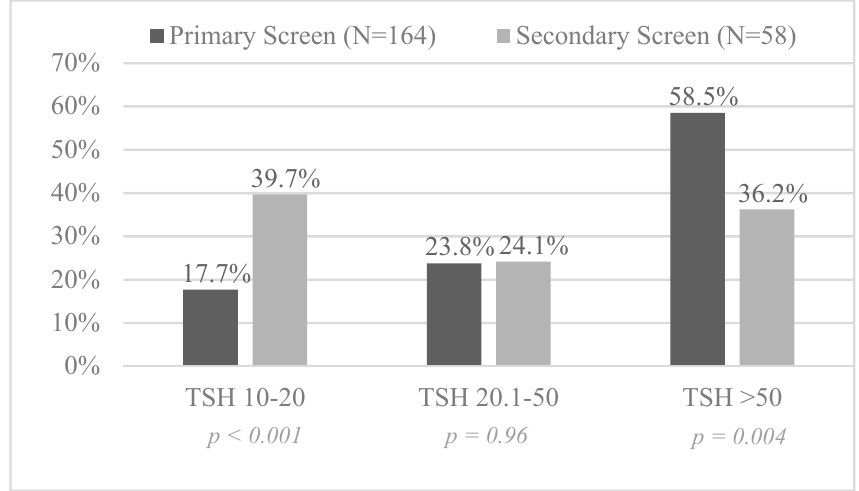
Figure 2. Comparison of initial TSH (mIU/L) levels at time of diagnosis of CH in patients detected on primary vs. secondary screening.